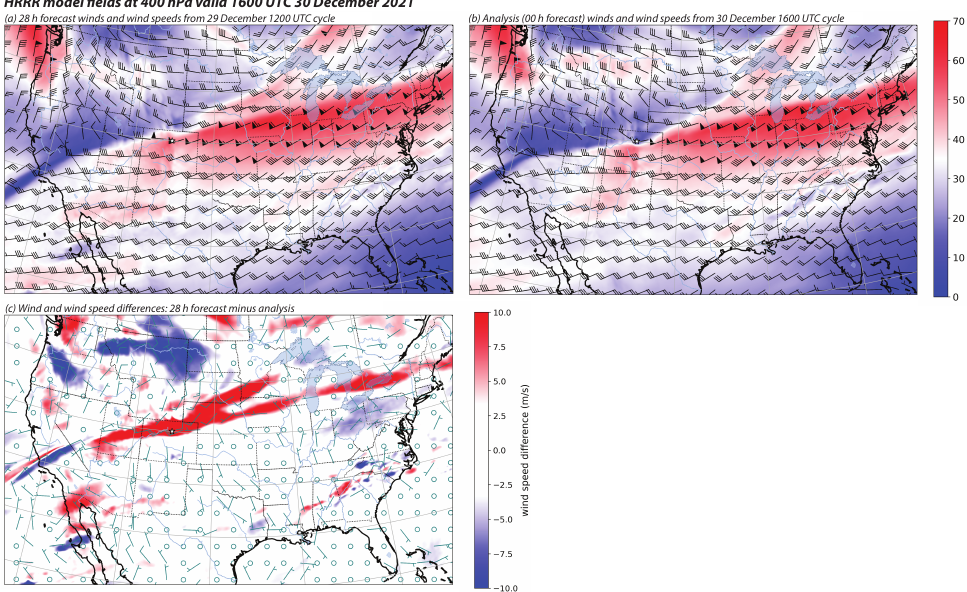
Figure 8. 400 hPa winds and wind speeds (shaded, m/s) from HRRR model forecasts valid 1600 UTC 30 December 2021, representing the ( a ) 1200 UTC 29 December cycle’s 28 h forecast, and ( b ) the 1600 UTC 30 December cycle’s analysis. Panel ( c ) shows difference fields of winds and wind speeds subtracting the analysis from the